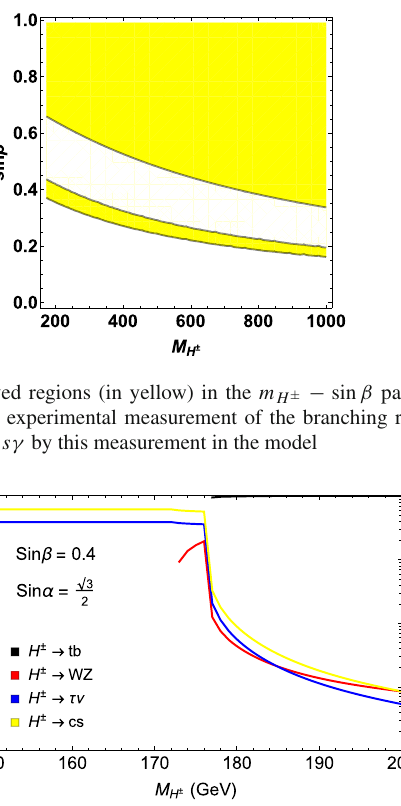
Fig. 15 The plot shows the branching ratio for different channels which are kinematically allowed for a light charged